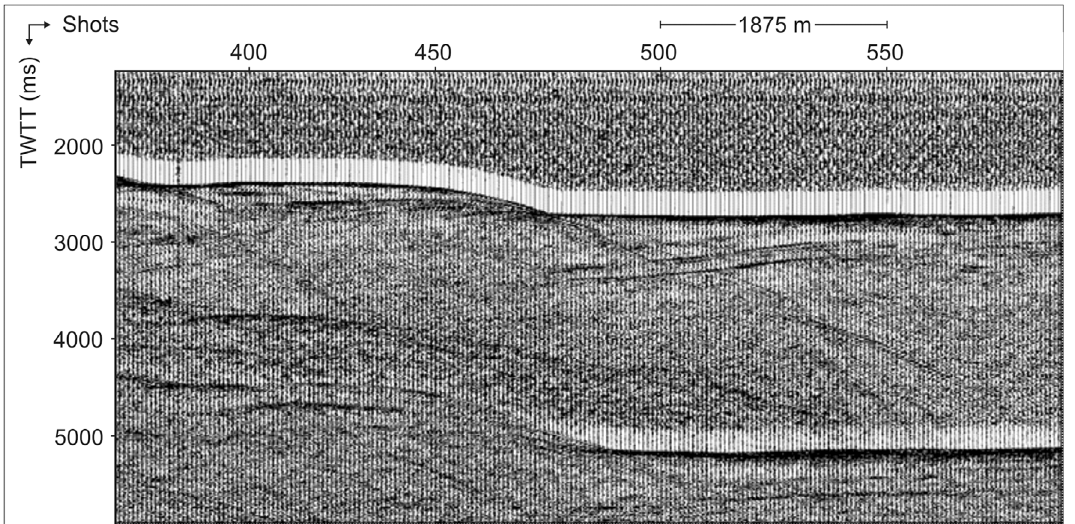
Figure 5. Common-offset trace display of a seismic line acquired during the R/V “Sarmiento de Gamboa” cruise. To get a preliminary view of the data quality, it is common practice to display a single-channel section composed of individual traces extracted shot by shot from the whole dataset. The section shown here (line T_11_MCS, Ionian Sea) is composed by the 100th of 240 traces only. The distance between traces is the same as the shot point interval (37.5 m).